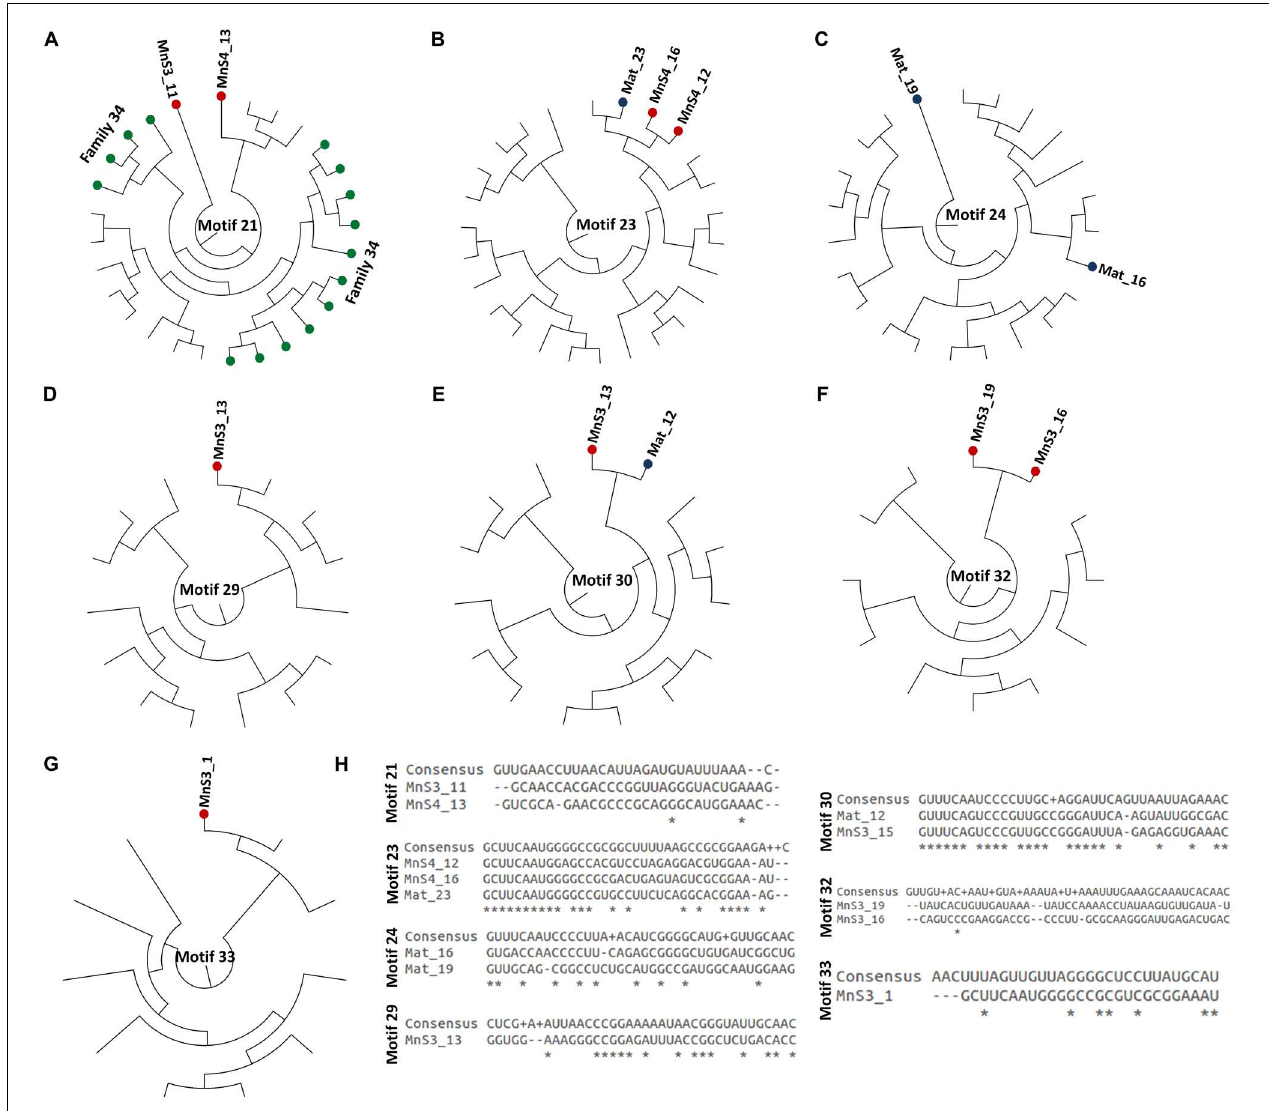
FIGURE 4 | (A–G) Dendrogram showing the relationship between repeat consensus sequences of motifs of CRISPR cassettes identified across microbial mat and sediment metagenomes, where red and blue nodes represent the repeat sequences belonging to the sediment and microbial mats. Green nodes represent the sequences in the CRISPR database with the family level assignments. All the sequences here were used from the CRISPR database with known motif level assignments. (H) Alignments between the consensus repeat sequences generated for specific CRISPRs motif and the repeat sequences identified in microbial mat and sediment